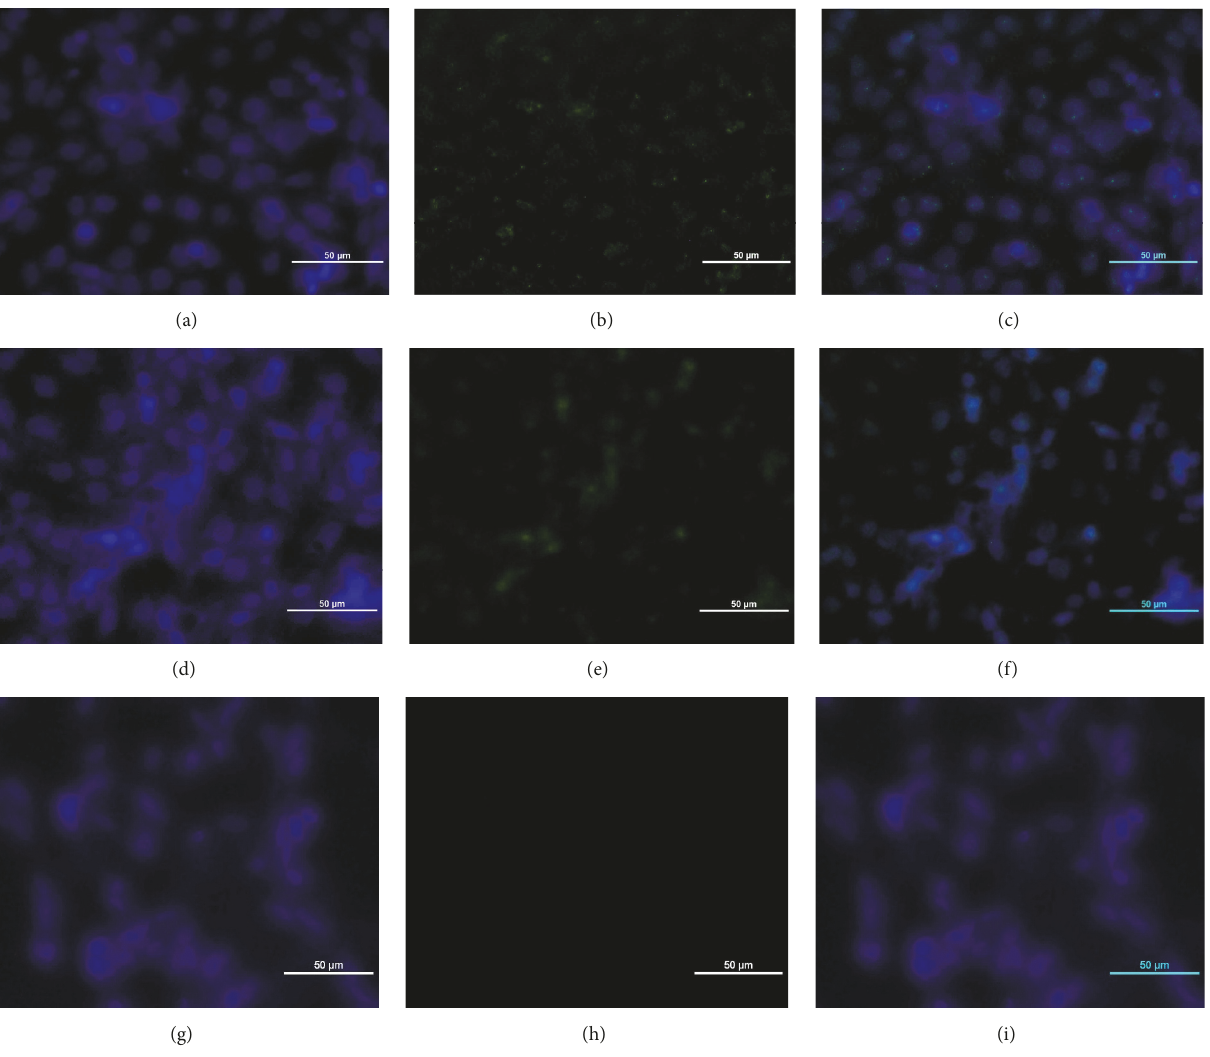
Figure 7: The indirect immunofluorescence test on the bioreactor propagated UPM0081EP12BGMP15BP1 and UPM190EP12BGMP15BP1 showing high amount of IBDV antigen within the cytoplasm of BGM-70 cells at 72 hours after inoculation. ((a) to (c)) BGM-70 cells infected with bioreactor propagated UPM0081EP12BGMP15BP1 and ((d) to (f)) UPM190EP12BGMP15BP1 showing positive signals for VP2 antigen (green)whenstainedwithFITC-conjugatedanti-chickenantibodyraisedagainstchickenanti-VP2antibody.((g)to(i))Uninoculatedcontrol. Bar=50 𝜇